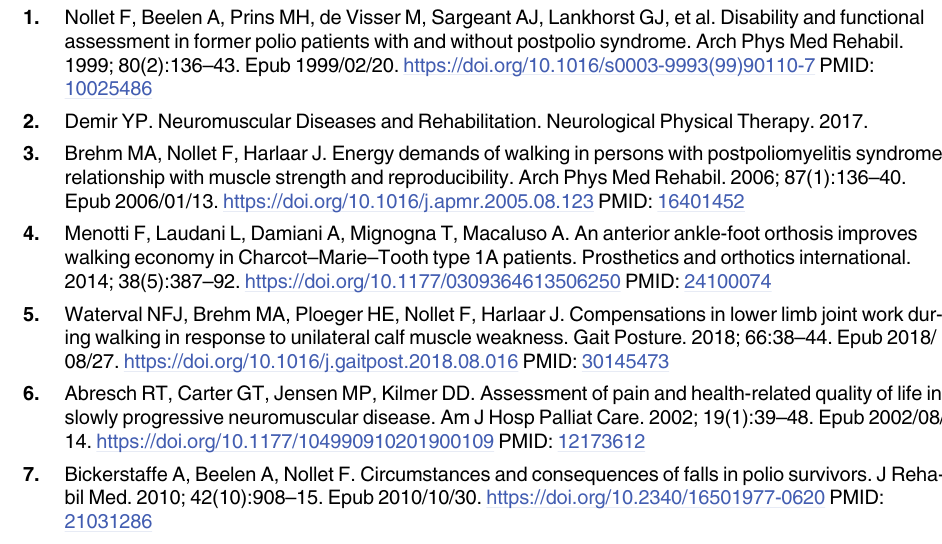
S1 Fig. Schematic presentation of the process description medical devices